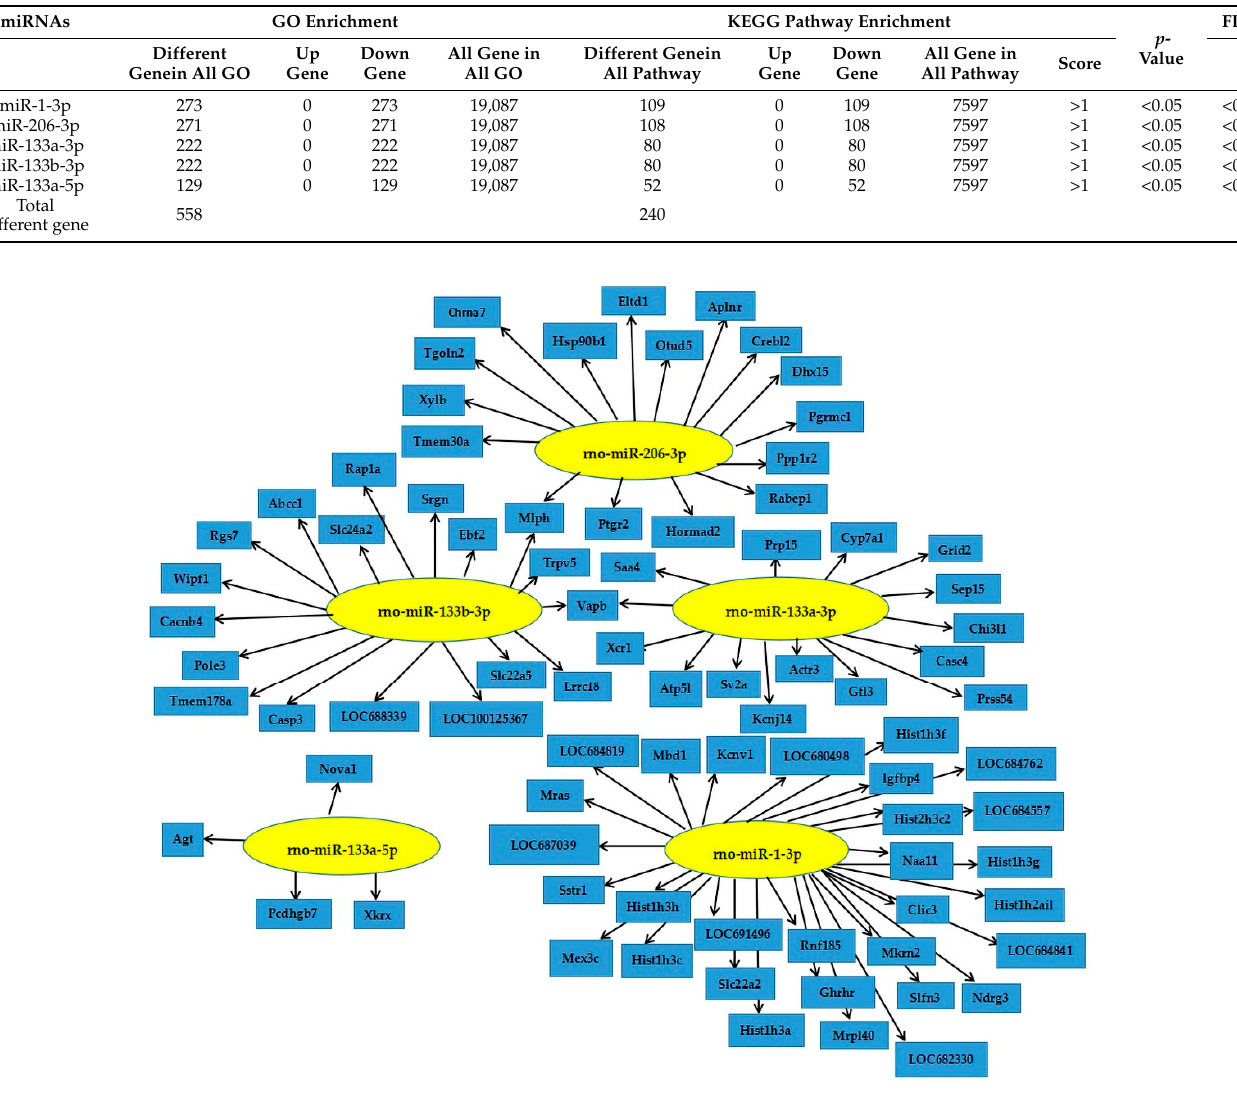
Figure 5. Regulatory pathway of differently expressed miRNAs.